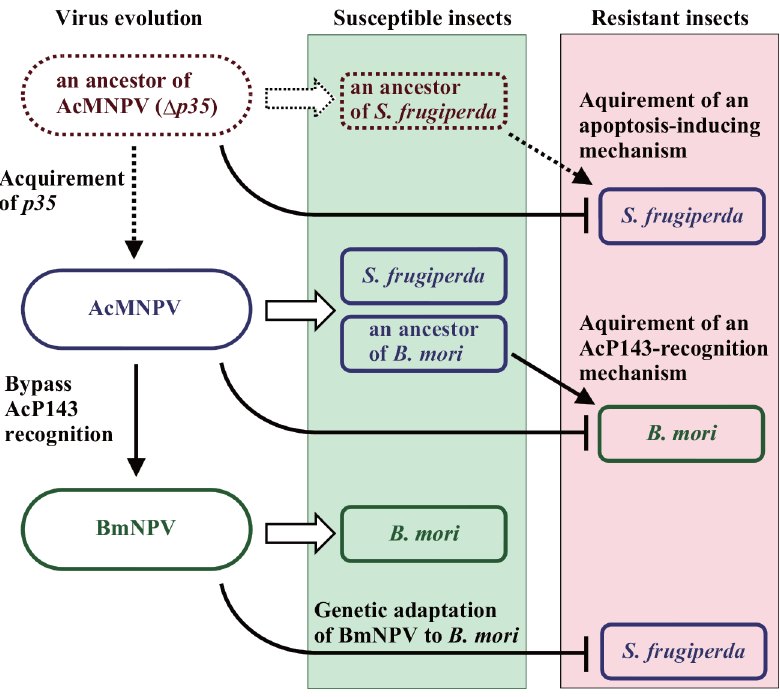
Fig 4. A possible scenario illustrating phylogenetic separation of BmNPV from AcMNPV. See text for